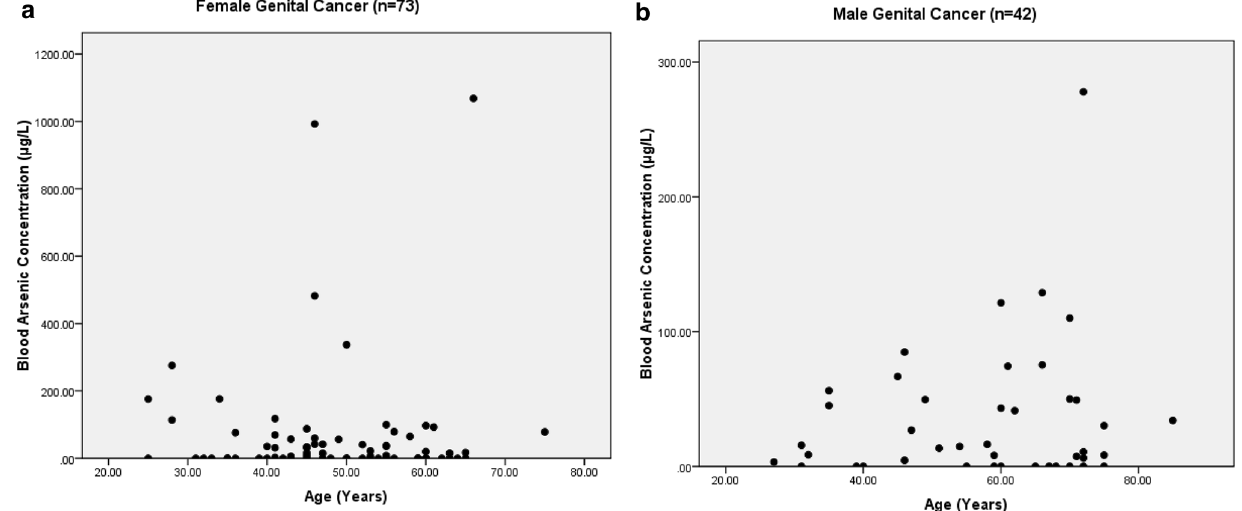
Figure 16. The correlation coefficient between blood arsenic levels and age of the female vs male genital cancer patients (P < 0.05).